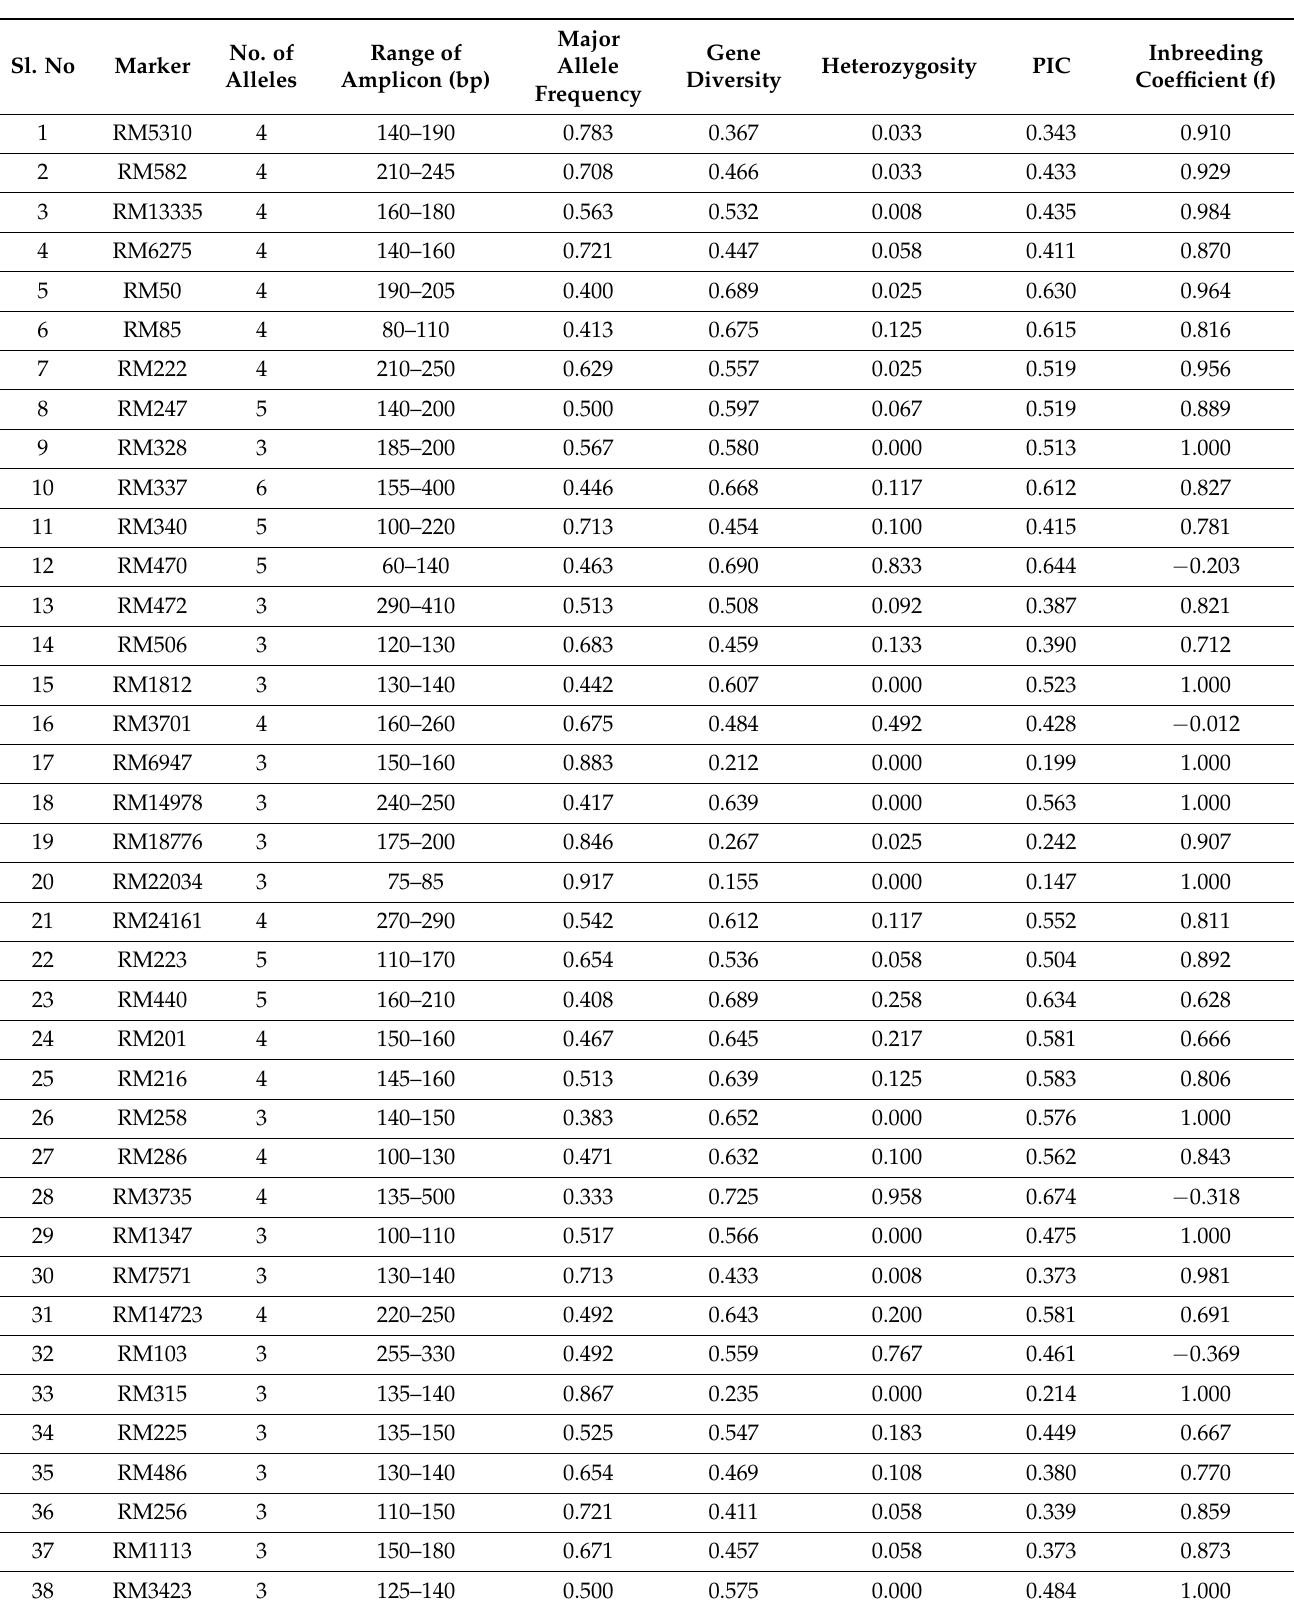
Table 2. Estimation of genetic diversity parameters based on 136 SSR marker loci in a panel containing 120 rice germplasm